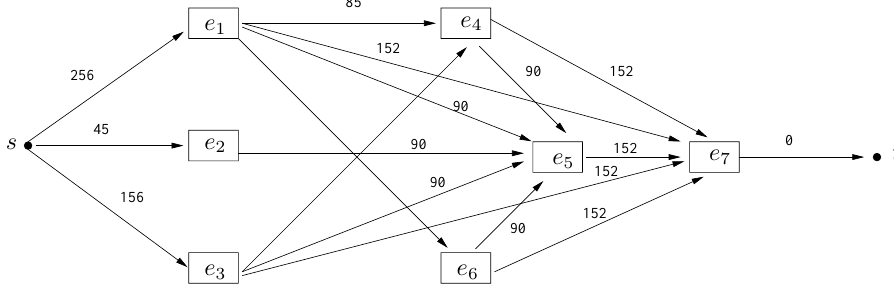
Figure 2: An example of a graph representing all the possible chains of the exons in E